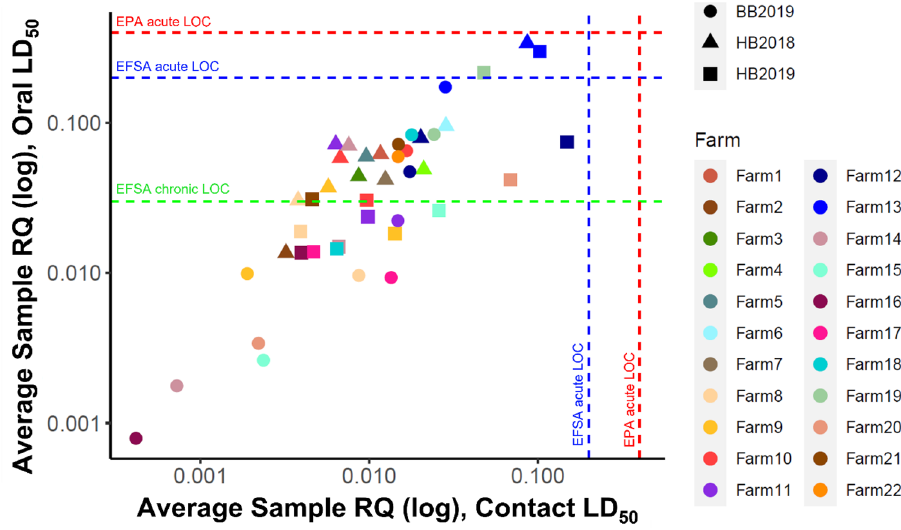
Figure 4. Average pollen sample risk quotient at each farm where pollen was collected from honey bees in 2018 (triangles) and 2019 (squares) and bumble bees in 2019 (circles). Contact (x-axis) and oral (y-axis) LD 50 values were used to calculate risk quotient using Apis mellifera toxicity values for honey bee pollen, and Bombus terrestris values were used whenever possible for bumble bee pollen. RQ is displayed in relation to the EPA and EFSA levels of concern (proportion of the LD50). The green dashed line is the EFSA level of concern (LOC) for chronic oral exposure (0.03). The blue dashed line is the EFSA level of concern for acute exposure (0.2), and the red dashed line is the EPA level of concern for acute exposure (0.4). However, EPA and EFSA do not use acute LOCs for oral exposure. These are included on the y-axis for illustrative purposes only. Graph created in R version 4.1.1 47 with the package ggplot2 110